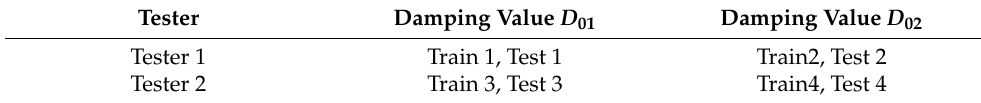
Table 1. Training set and test set under different experimental